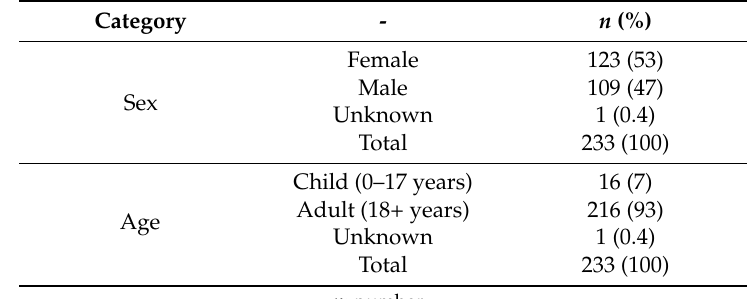
Table 2. Demographics of presumptive tuberculosis (TB) patients in the Balimo region of Papua New Guinea (PNG), from samples collected as part of routine passive case detection activities at Balimo District Hospital (BDH). Out of 240 samples initially collected, a total of 236 samples originating from 233 patients were analysed, as three patients had both new and follow-up samples collected, and four samples were duplicates.